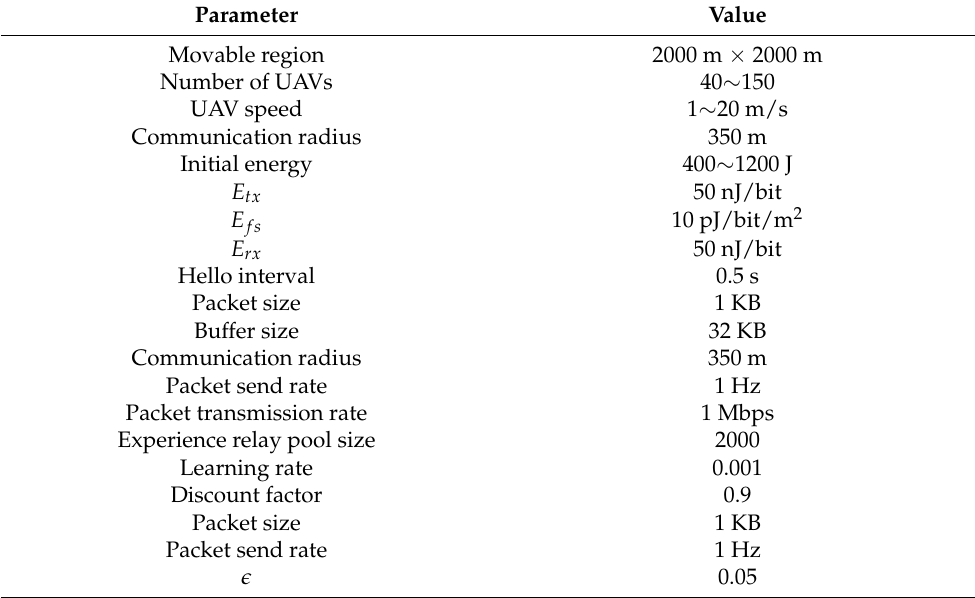
Table 2. Simulation parameter.